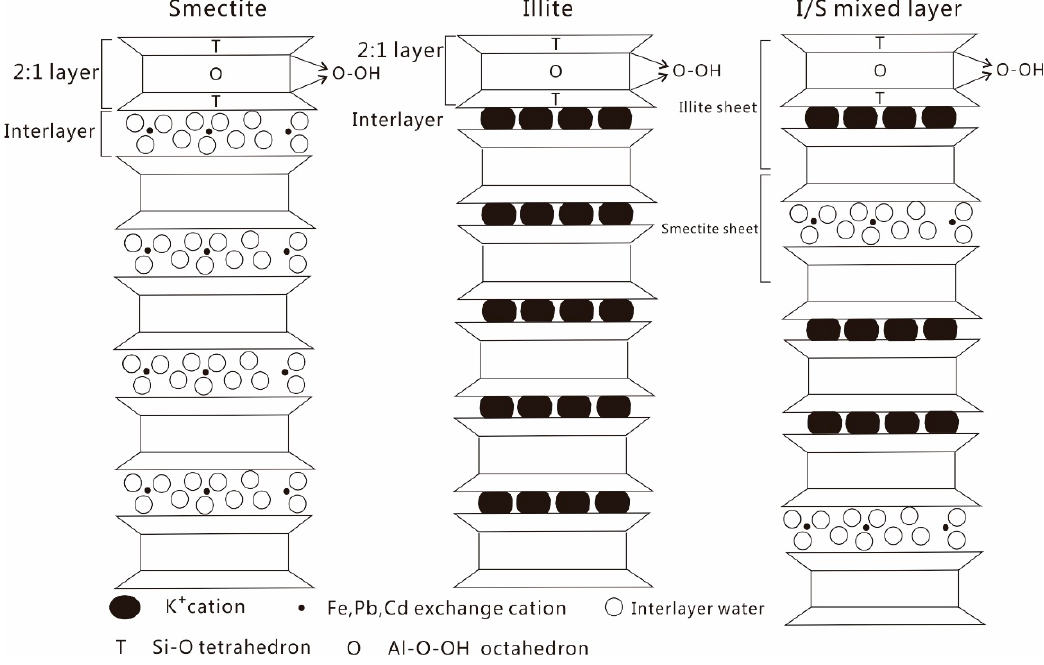
Figure 1. The structure of smectite, illite, and I/S mixed layer.